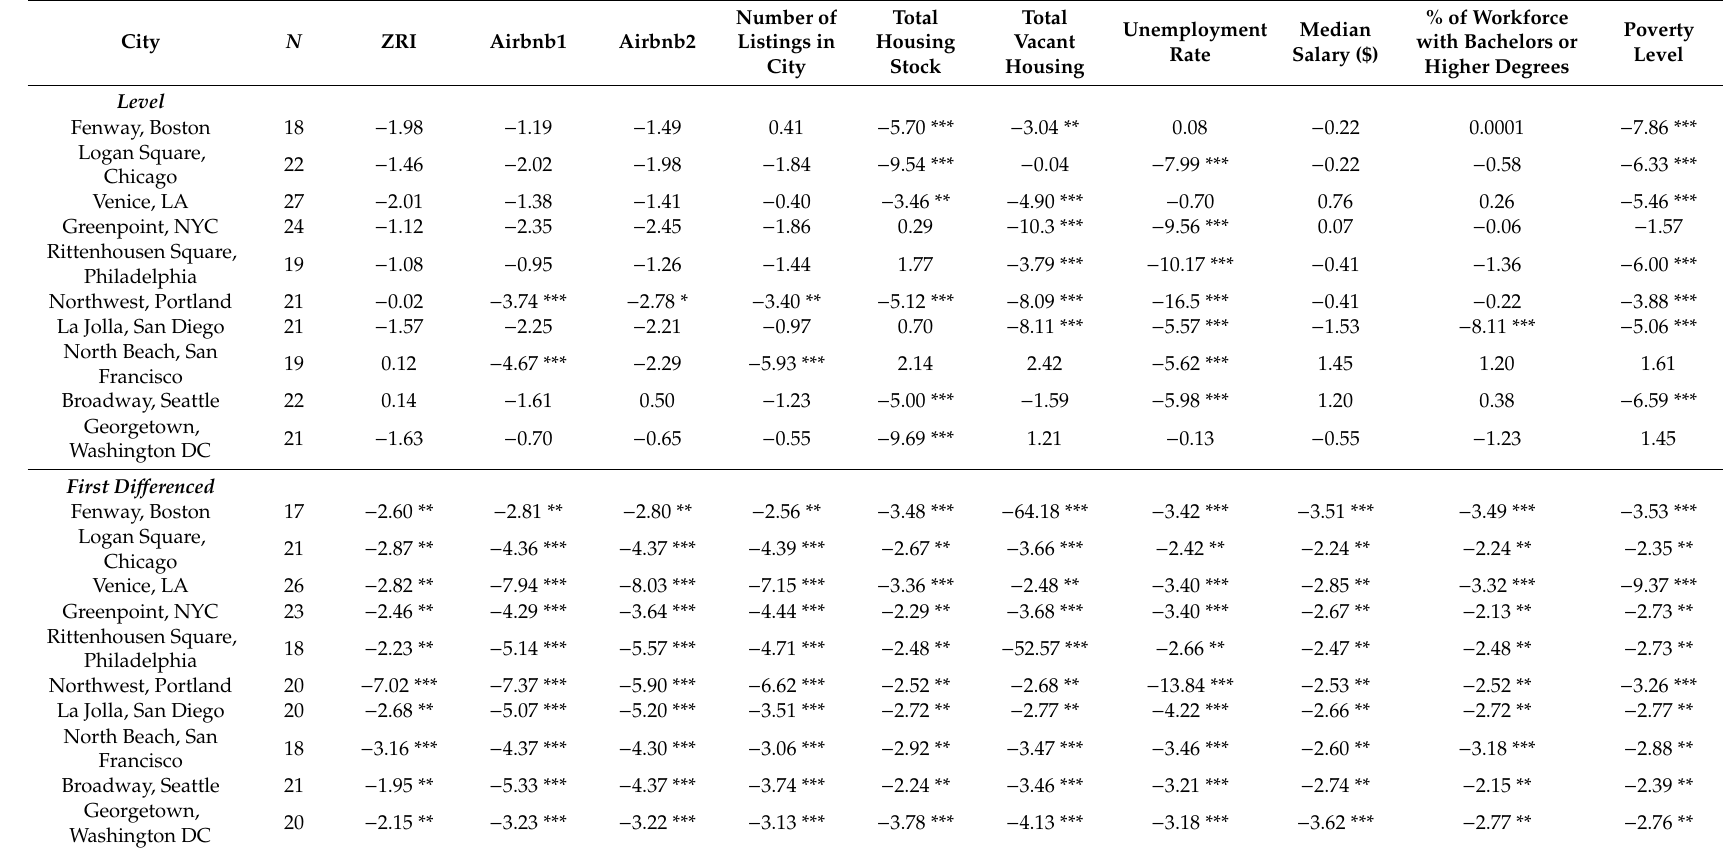
Table 4. Unit Root Test Results (level and first di ff erenced